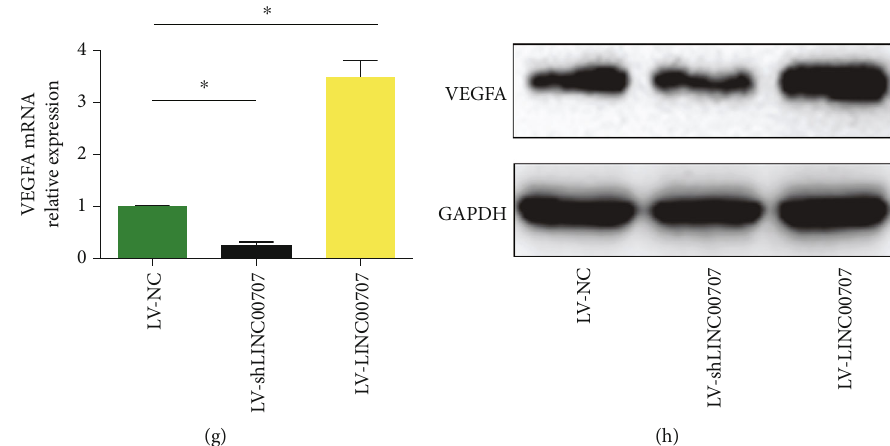
Figure 6: Loss of LINC00707 restrained cervical cancer growth through sponging miR-382-5p in vivo. BALB/c nude mice were injected with C-33A cells infected with LV-NC (six mice) or LV-LINC00707 (six mice) or LV-shLINC00707 (six mice). (a) Tumor volume in a time- dependent manner. (b) Tumor weight when the mice were sacri fi ced. (c) Tumor volume when the mice were sacri fi ced. (d) IHC analysis of Ki-67 ( scalebar = 50 μ m). (e) Expression of LINC00707. (f) Expression of miR-382-5p. (g, h) Expression of VEGFA. ∗ P < 0 : 05